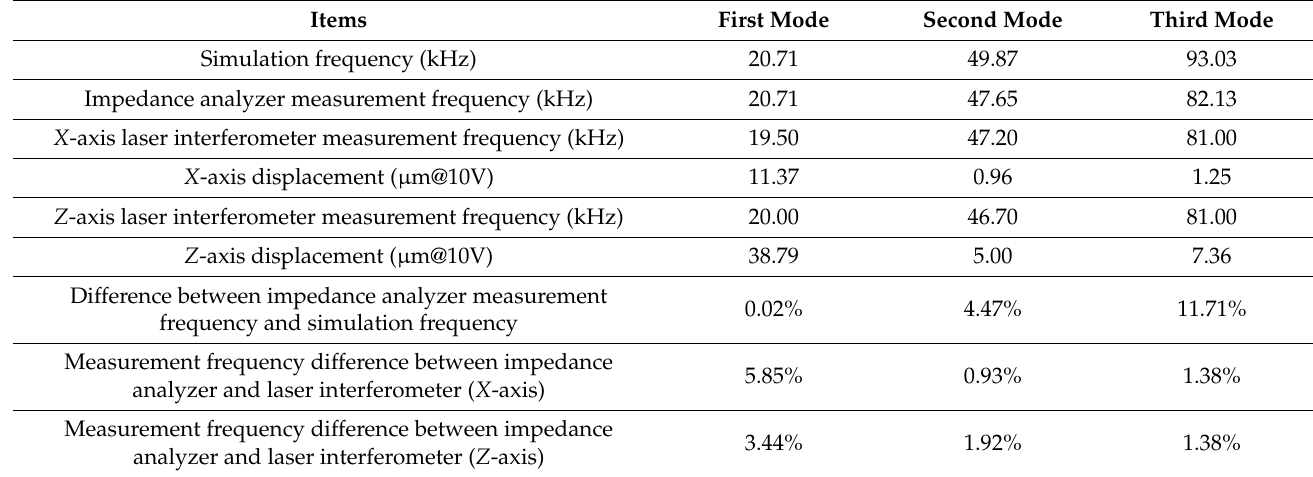
Table 2. Simulation and measurement comparison of the multi-layer bimorph